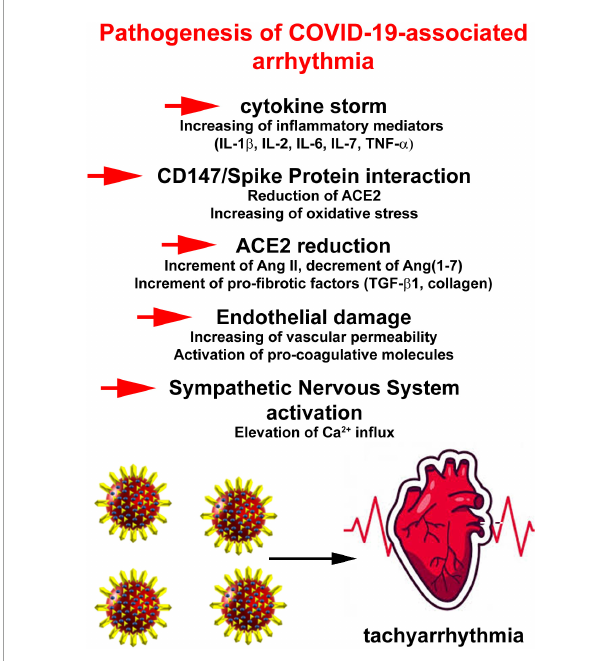
FIGURE2 Pathophysiology of COVID-19-related atrial fibrillation (AF) events. Putative mechanisms include a reduced availability of angiotensin-converting enzyme 2, binding of viral spike protein to CD147 or sialic acid, enhancement of inflammatory signaling culminating in cytokine storm, endothelial damage, and increased adrenergic